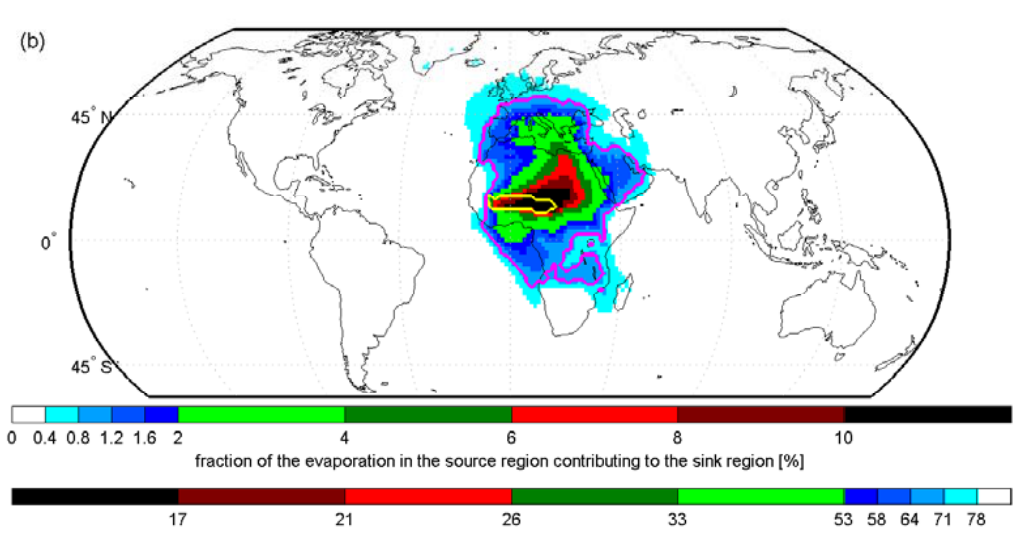
Figure 3. Precipitationsheds of the West Sahel sink region: (a) The absolute precipitationshed of the West Sahel sink region (yellow border), expressed in terms of absolute evaporation mm/growing season contributed to sink region precipitation; (b) The relative precipitationshed of the West Sahel sink region (yellow border), expressed in terms of a fraction of the evaporation contributed to sink region precipitation. The second color scale in (a) and (b) indicates which percentage of the precipitation in the West Sahel region is generated within the area indicated by the corresponding colors. The pink border in (b) (= the gray border in Fig. 4) is the relative precipitationshed for the West Sahel region (at 70% contribution). The West Sahel sink region receives an average of 301 mm of precipitation per growing season. See Supplemental Figs. S2–S7 for the absolute and relative precipitationsheds of the other six sink